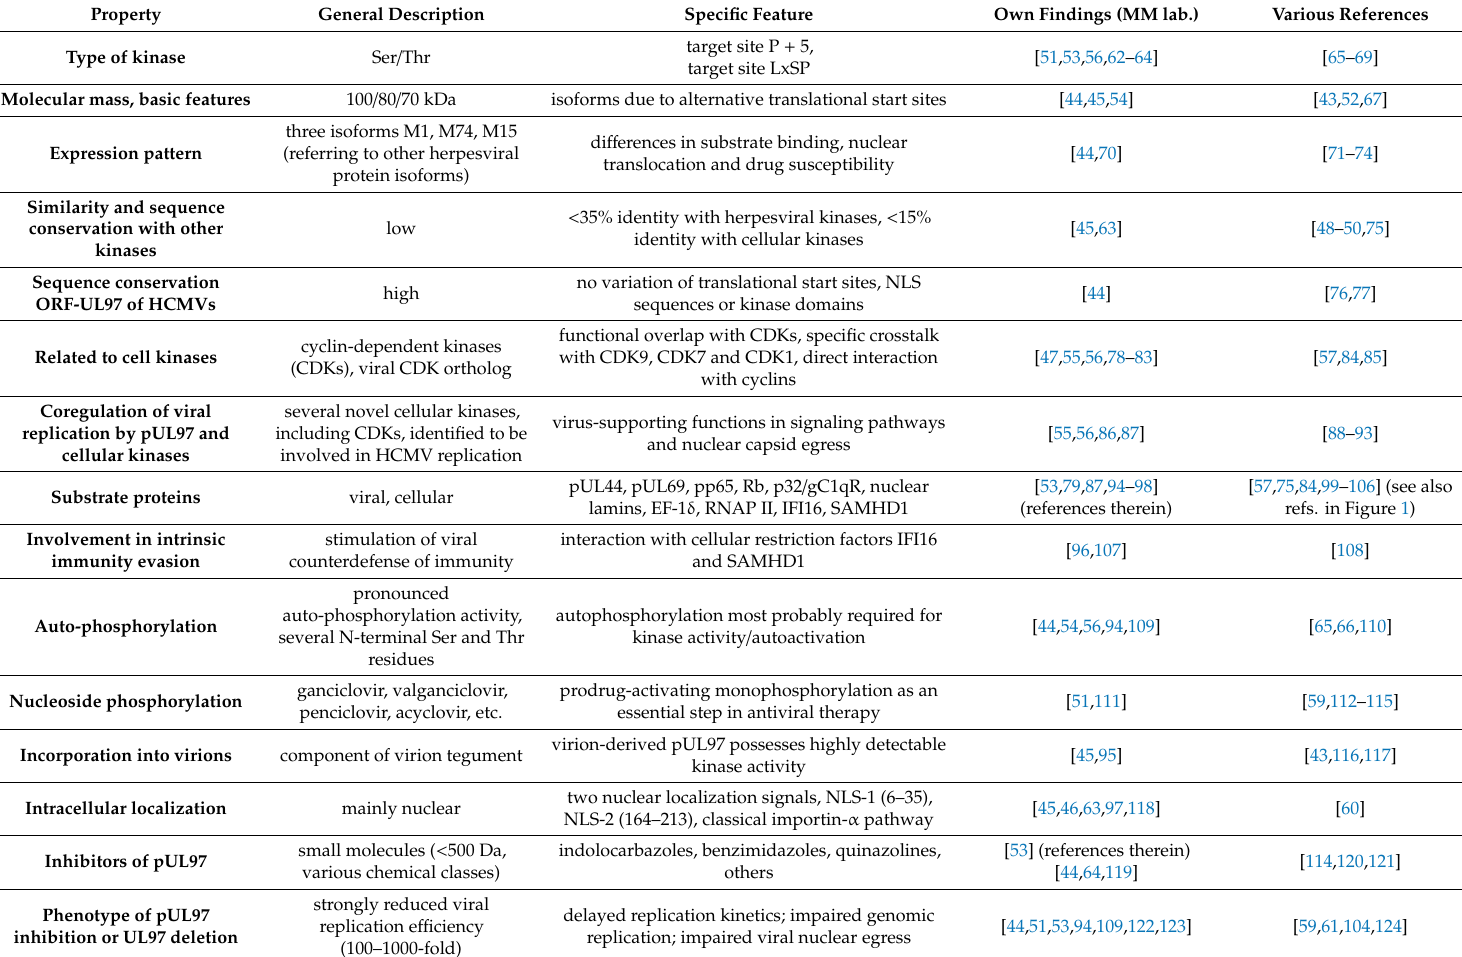
Table 1. Characterization of the molecular features and functional properties of the HCMV protein kinase